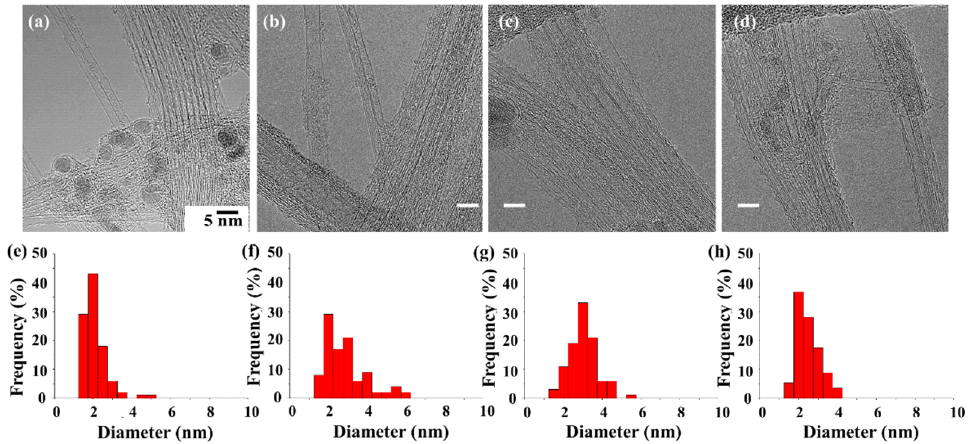
Figure 1. TEM images ( a – d ) and size distribution ( e – h ) of synthesized CNTs with different catalyst precursors: ( a ) ferrocene, ( b ) acetylferrocene, ( c ) ferrocenemethanol, and ( d ) 1,1′-diacetylferrocene.